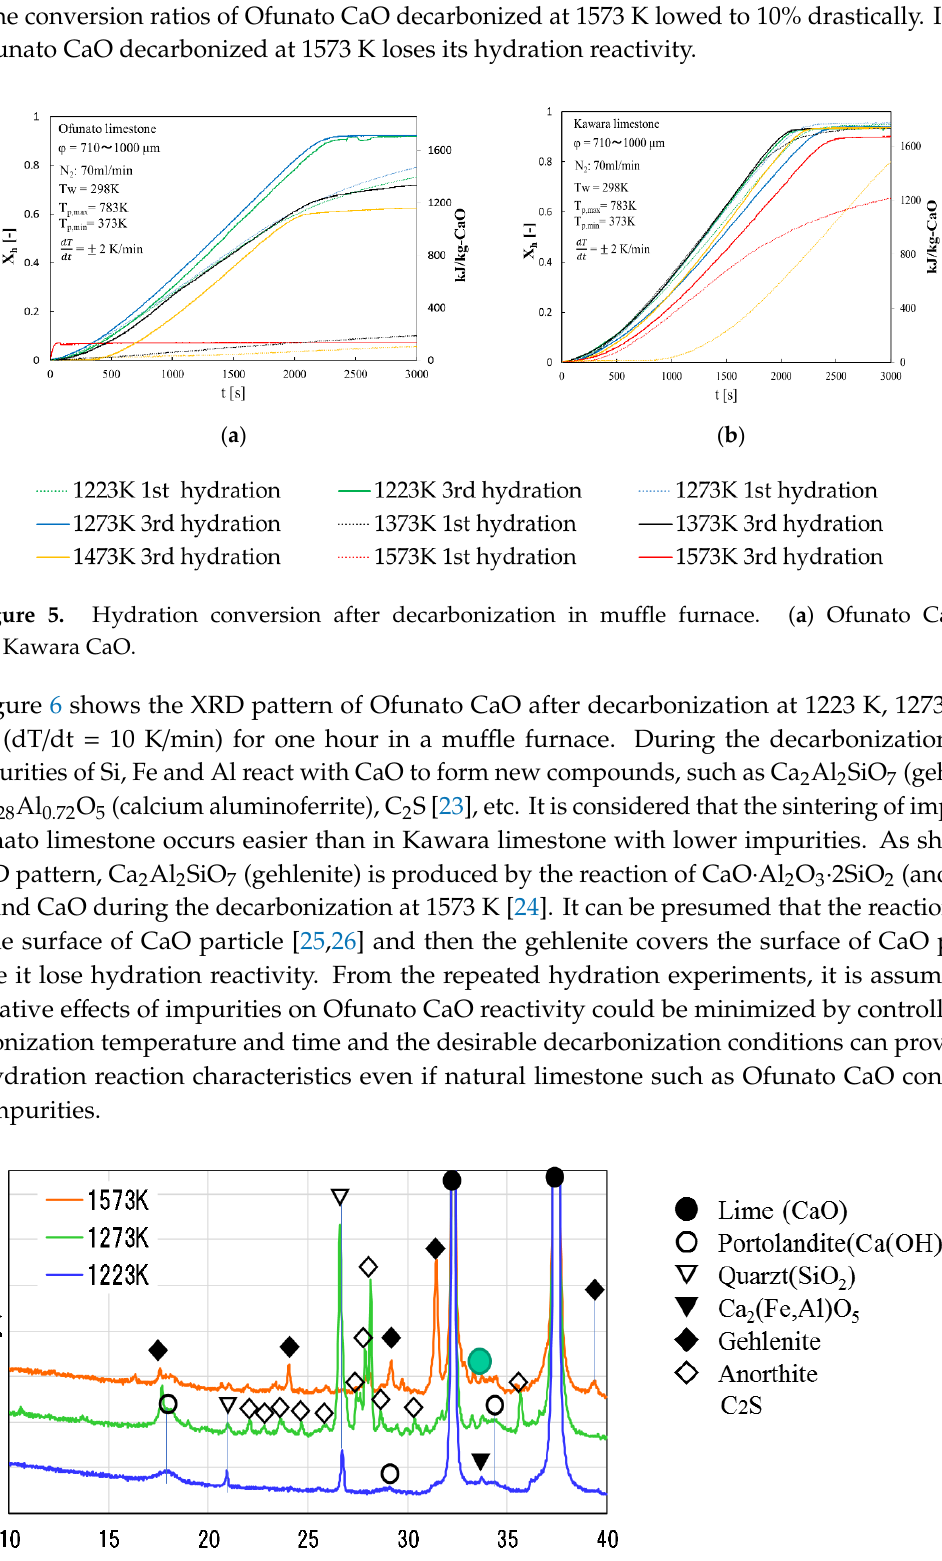
Figure 6. XRD pattern of Ofunato CaO after decarbonization at 1223 K, 1273 K and 1573 K.